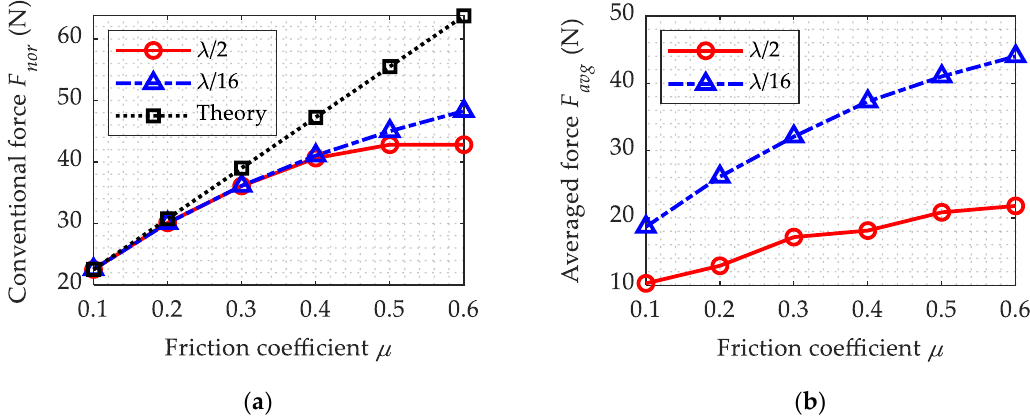
Figure 12. Influence of friction coefficient on drawing forces when the die locates at different positions: ( a ) Influence of friction on conventional drawing force; ( b ) Influence of friction coefficient on averaged ultrasonic drawing forces.